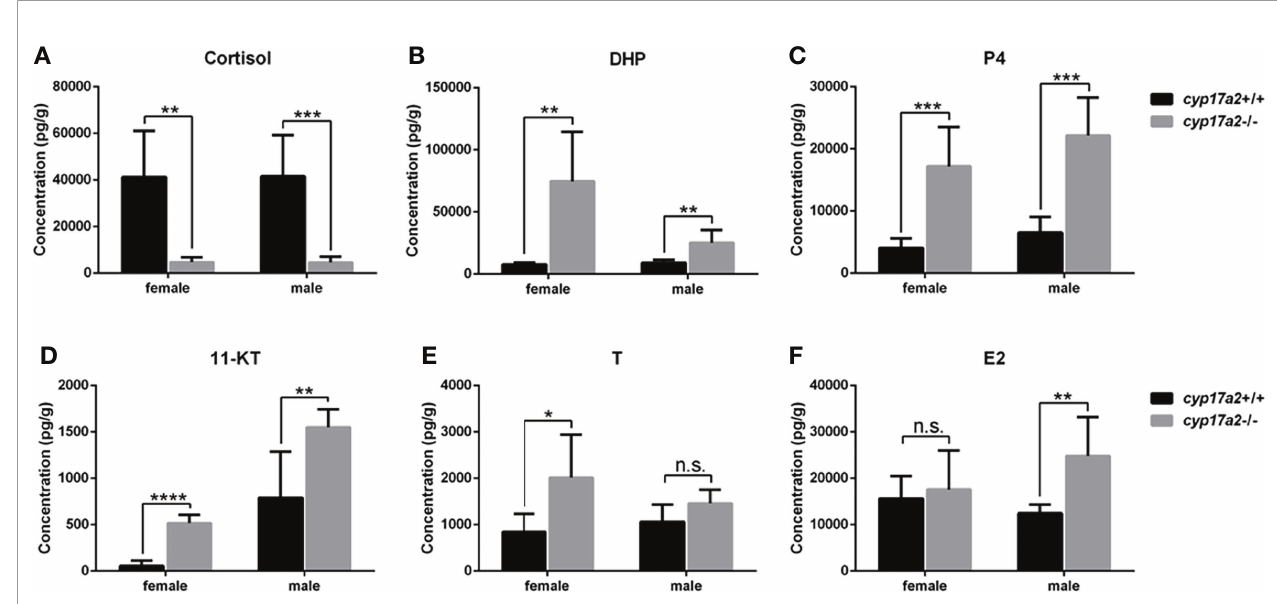
FIGURE 3 | The steroid measurements. Whole-body levels of cortisol (A) , DHP (B) , P4 (C) , 11-KT (D) , T (E) , and E2 (F) in cyp17a2 +/+ and cyp17a2 -/- zebra fi sh at 3 mpf (n = 6). n.s., no signi fi cant difference. * P < 0.05. ** P < 0.01. *** P < 0.001. **** P <